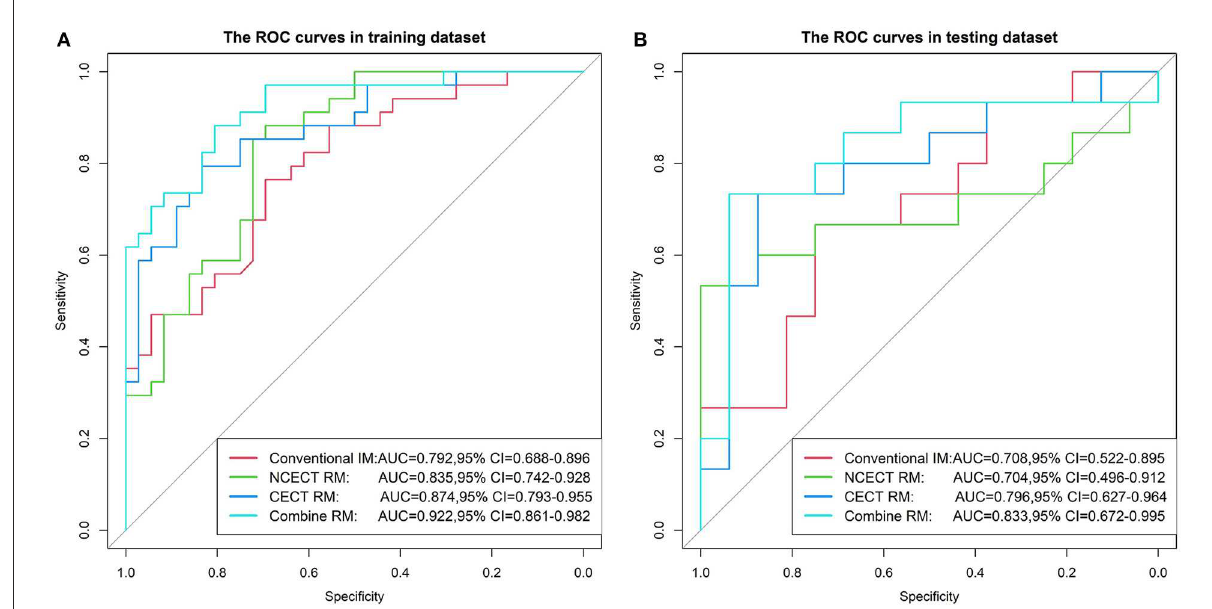
FIGURE3 The ROC curves for four models in the training set (A) and the test set (B) . The AUC of the CECT RM was greater than that of the NCECT RM and the conventional IM. The combine RM achieved the best performance, with AUC of 0.922 and 0.833. ROC, receiver operating characteristic; AUC, area under the ROC curve; NCECT, non-contrast enhanced CT; CECT, contrast-enhanced CT; RM, radiomics model; IM, imaging model.